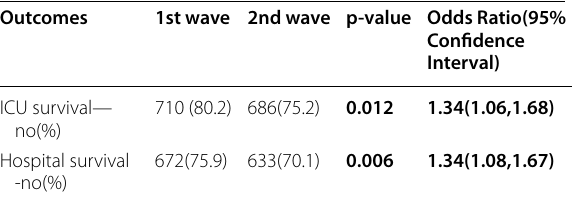
Table 2: Outcomes of wave 1 and 2